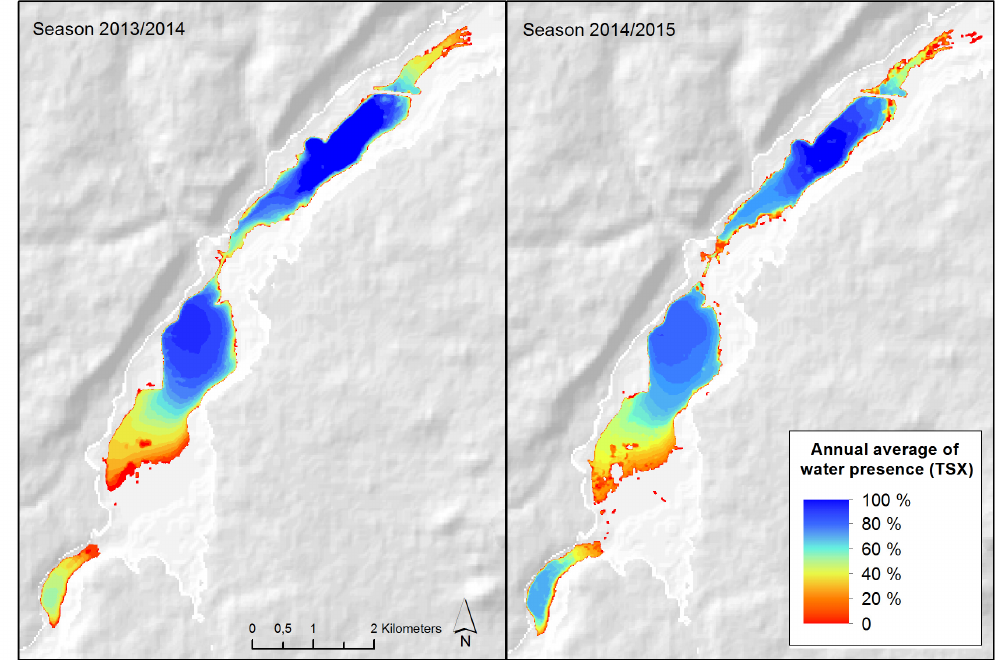
Figure 7. Annual average of water presence derived from TSX data in the seasons 2013/2014 (combination of 21 scenes from 2013- 08-17 to 2014-05-19, left) and 2014/2015 (combination of 26 scenes from 2014-07-02 to 2015-06-19, right) using the shaded relief from SRTM DEM.